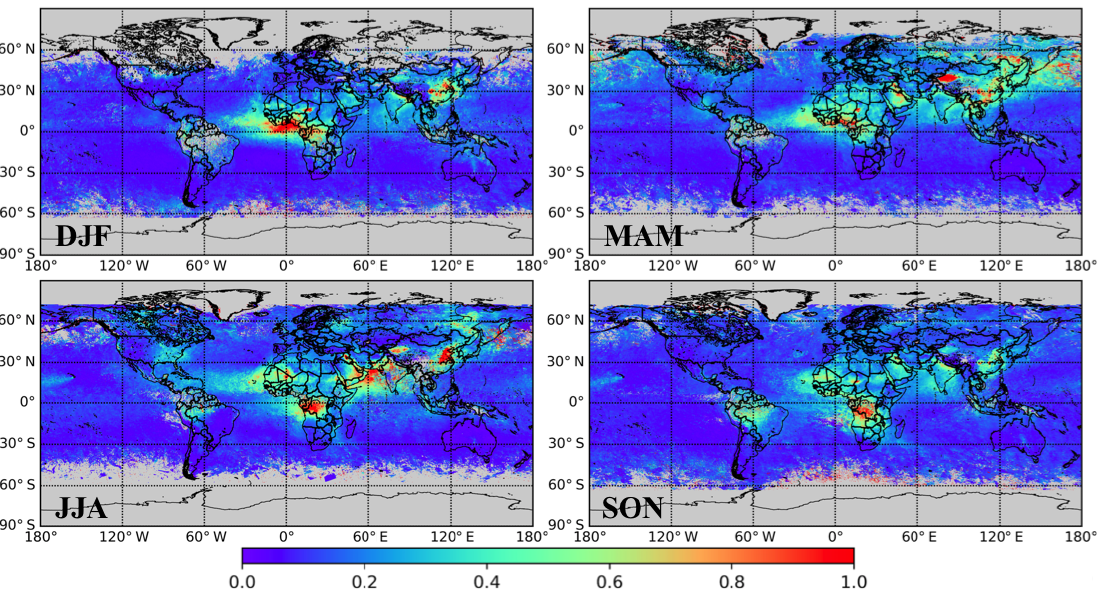
Figure 15. Seasonal variability of the AOT at 565nm in 2008 as retrieved by the GRASP/Component algorithm from POLDER/PARASOL satellite observations.